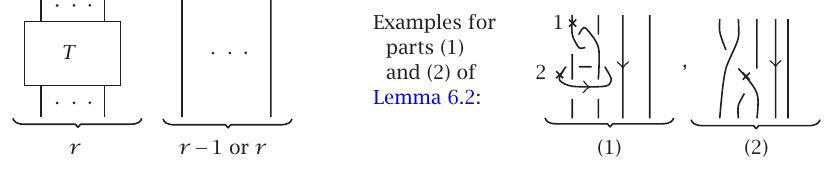
Figure 6.2 . Special tangles on an even or odd number of